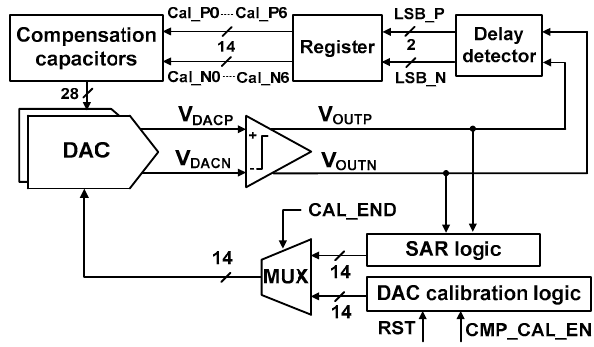
Figure 10. Block diagram for realizing DAC capacitor mismatch calibration.